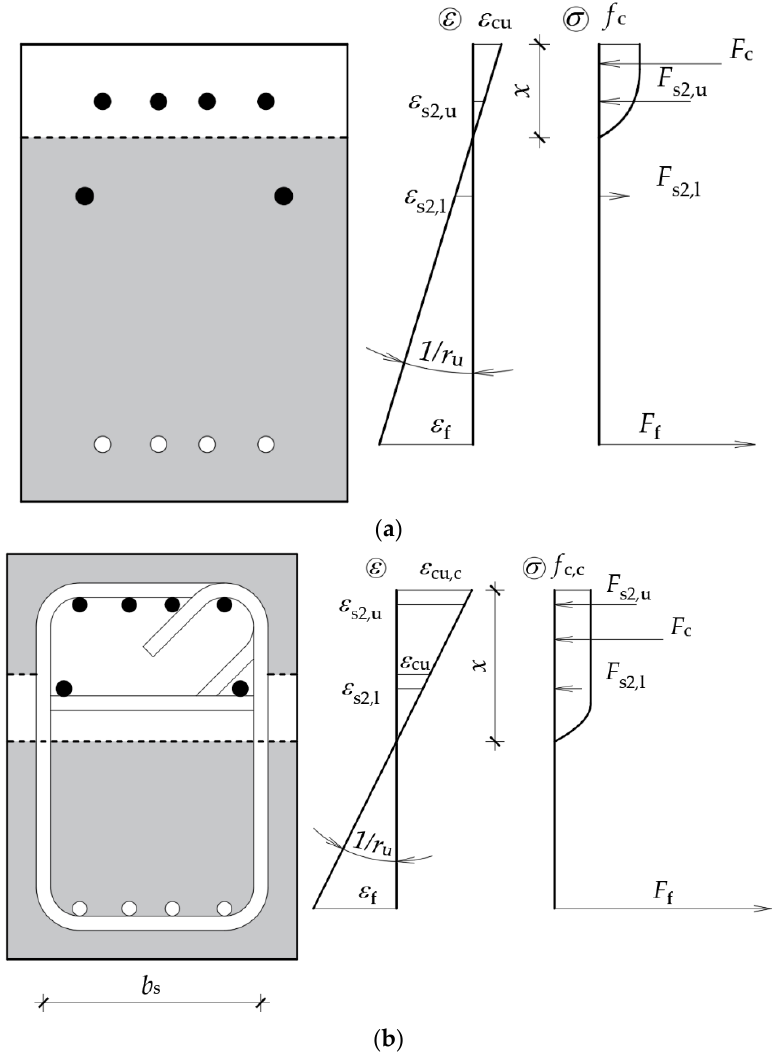
Figure 2. Ultimate state of FRP reinforced beams: ( a ) Unconfined section; ( b ) Confined section. In Figure 2, ε s2,u is the strain of upper compressive reinforcement, ε s2,l is the strain of lower compressive reinforcement, ε cu,c is the ultimate strain of confined concrete, f c,c is the strength of confined concrete, F s2,u is the force in upper compressive reinforcement, F s2,l is the force in lower compressive reinforcement, F c is the compressive force in concrete and F f is the force in FRP